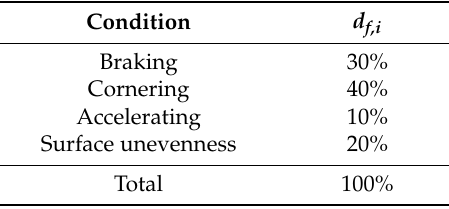
Table 10. Dynamic factors.